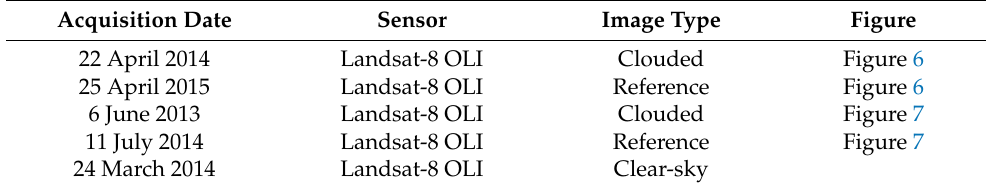
Table 1. Summary of the Landsat scenes acquired in different seasons (path/row: 122/34; size: 3545 ×